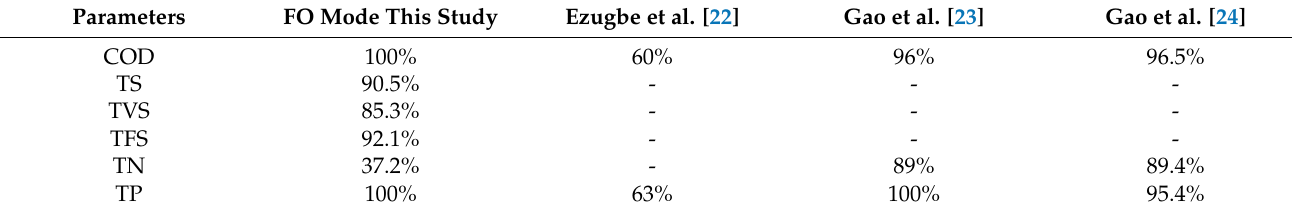
Table 8. Comparison of FO mode removal efficiency with previous